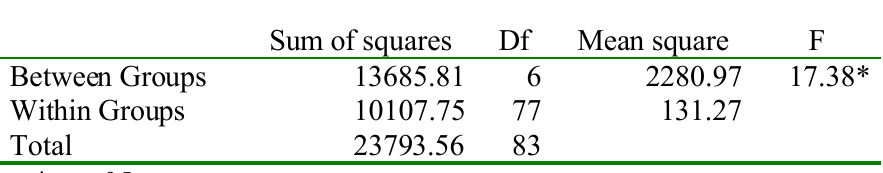
Analysis of Variance for Adjective Category